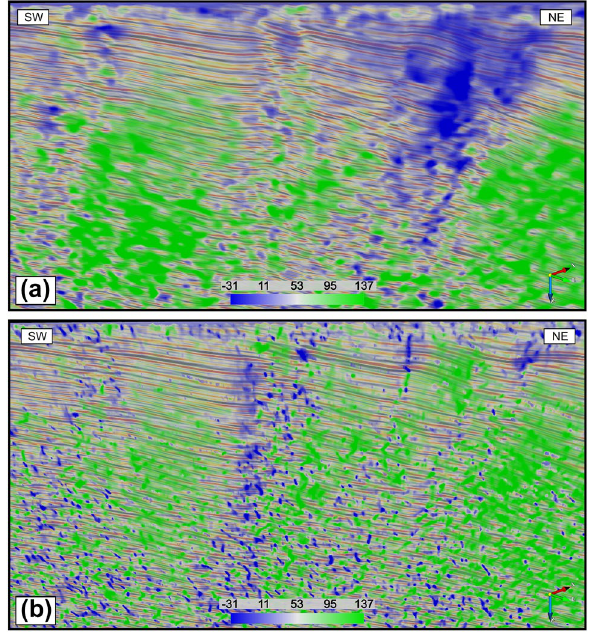
Fig. 6 The generated full steering data are overlayed on the seismic inline 10,730 dip section: a background steering data and b detailed steering data. The green color represents the dip, while the blue color represents the